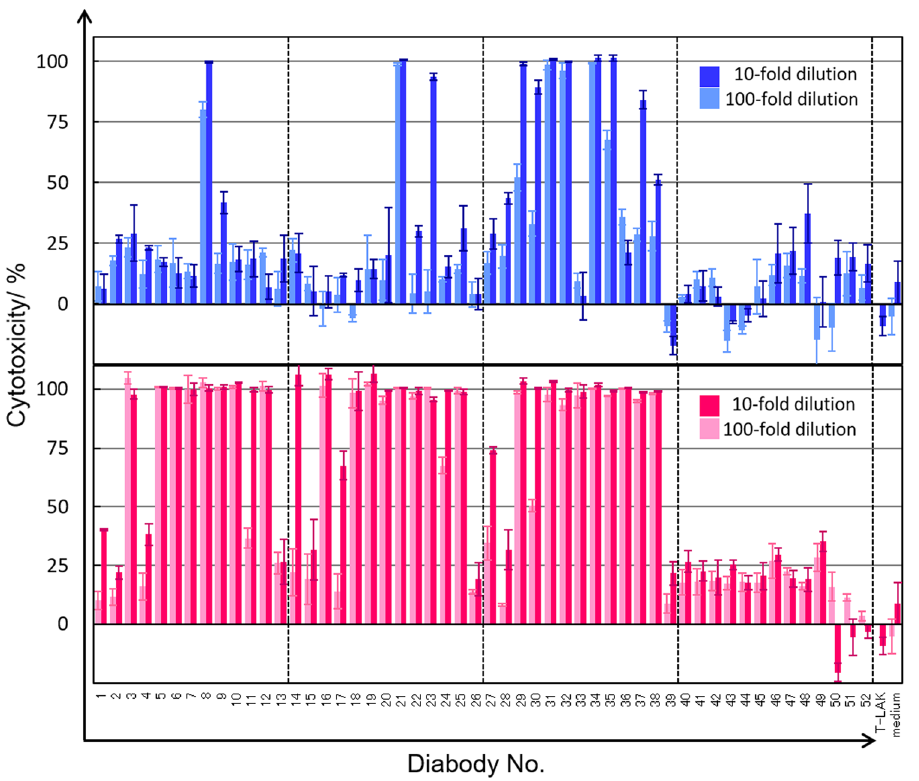
Figure 1. Cytotoxicity screening for culture supernatants of transformed E . coli against TFK-1 cells 10-fold or 100-fold diluted culture supernatants containing HL-type diabody (blue bar) or LH-type diabody (red bar) were applied to MTS assay. All the experiments were conducted three times, and data are presented as means ± S.D. In the horizontal axis, T-LAK indicates experiments without diabody but with T-LAK cells, and medium indicates experiments without diabody or T-LAK cells. Details of the diabodies nos 1–52 are presented in Table